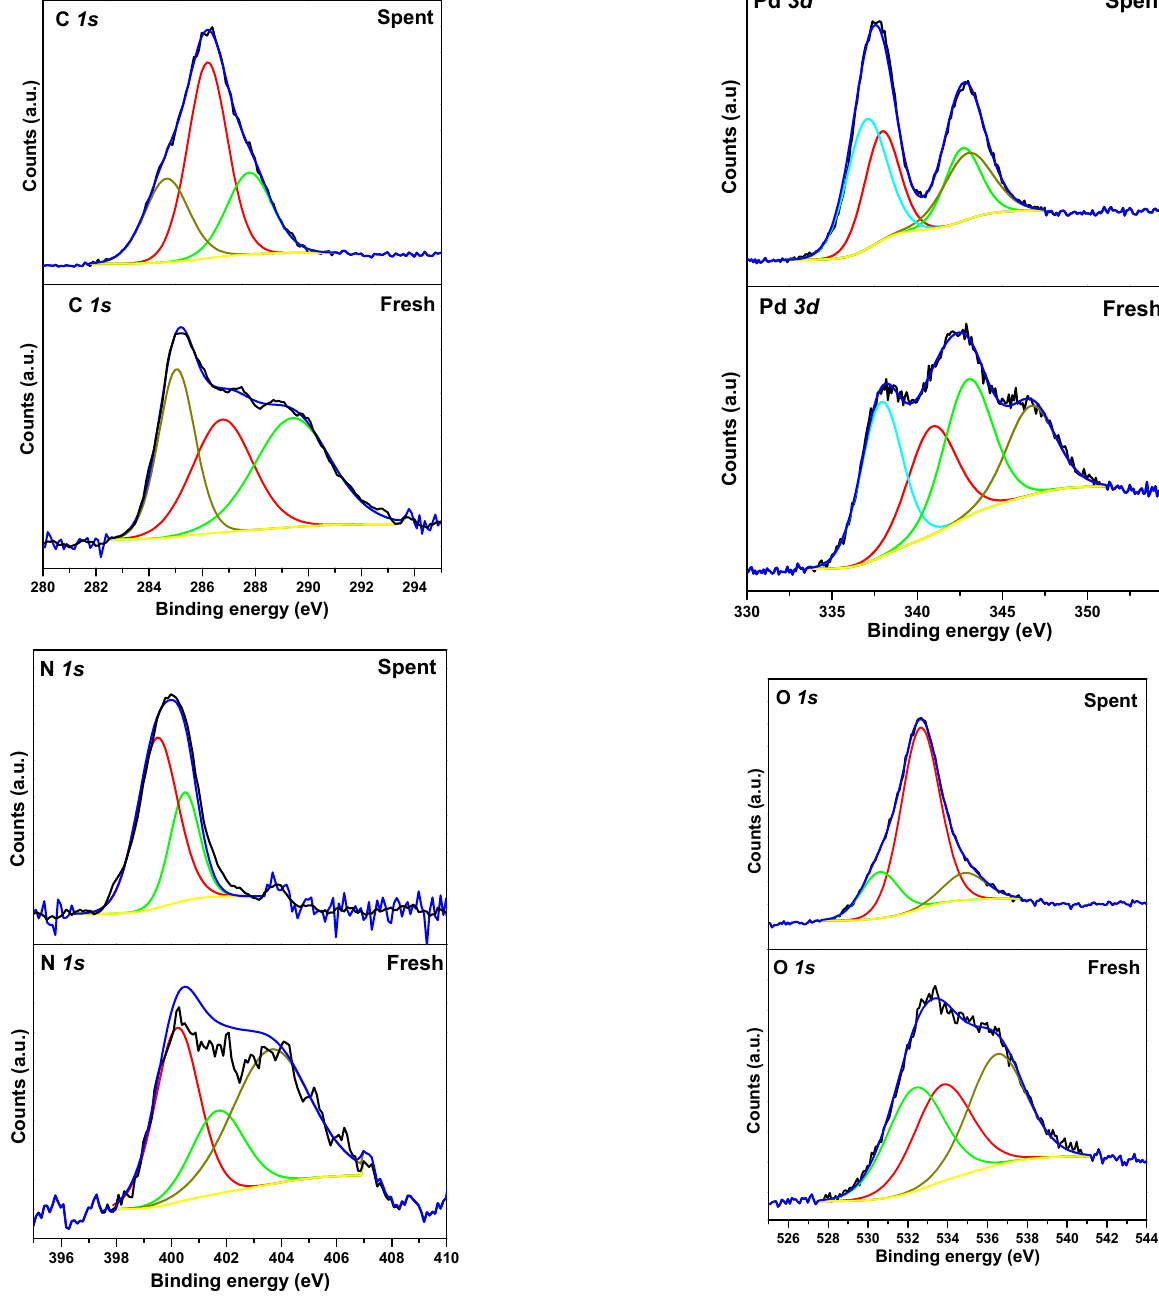
Figure 1. XPS spectra for the fresh and spent Pd@Chitosan samples.